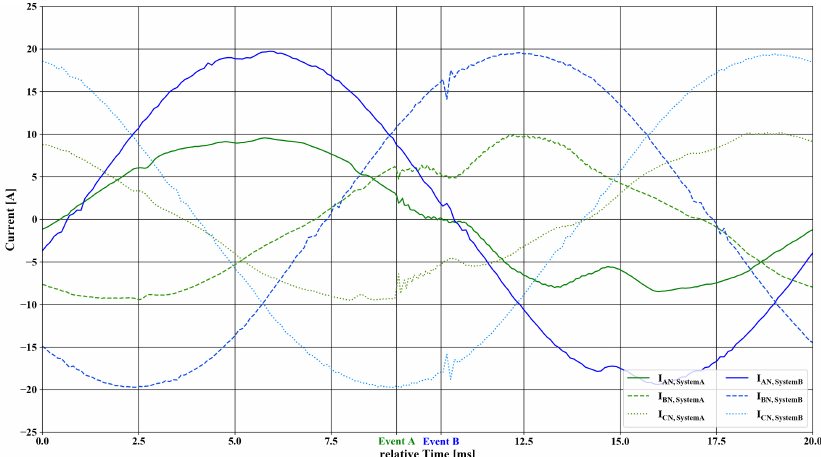
Figure 9. Comparison of the different transient system responses to the step for the current feed-in by the PV inverter. The currents of both three-phase systems are overlayed and synchronised. The occurrence of the step event is indicated separately for each